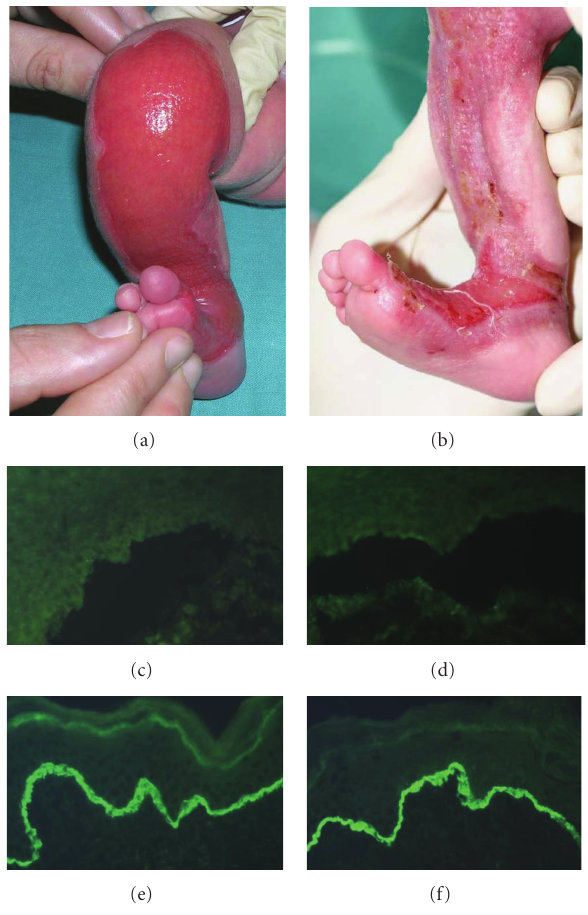
Figure 9: (a) Patient 4: shortly after birth, a large denuded area was found on the left leg. (b) The same leg four weeks later showing healing and scar formation. (c)-(d) IF antigen mapping of perilesional skin: absence of BPAG2 (c) and collagen type VII (d). (e)-(f) IF antigen mapping of clinically una ff ected skin (inner aspect upper arm): positive staining for collagen type XVII (e) and collagen type VII (f) ((c)–(f) original magnification: